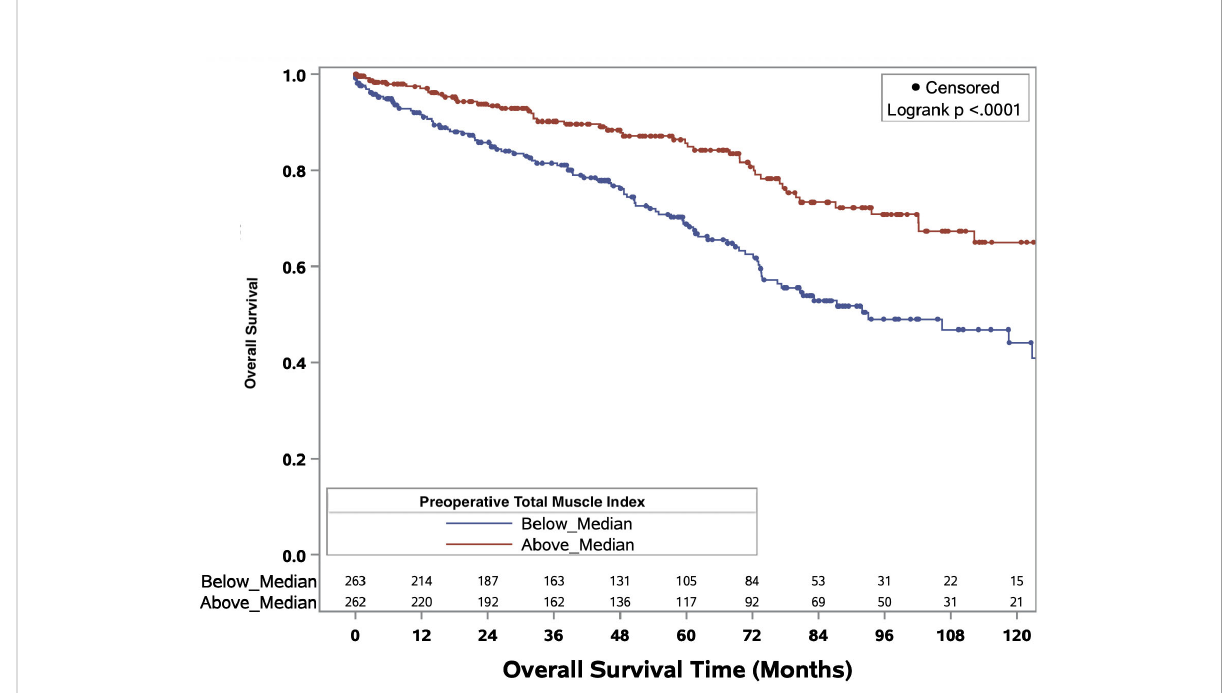
FIGURE 3 Kaplan-Meier curves evaluating median overall survival times in patients above or below median preoperative total muscle index for all RCC patients of any histology.